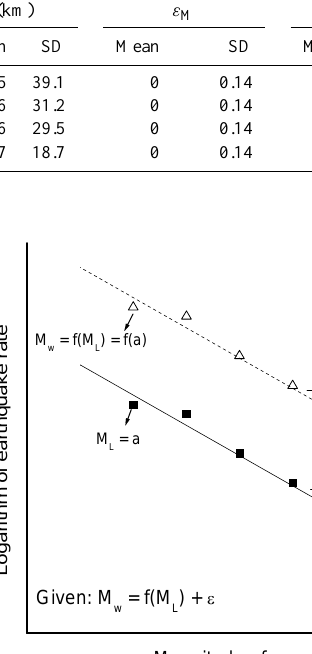
Table 1. Summary of the FOSM analyses for earthquake hazard assessment. Scenario